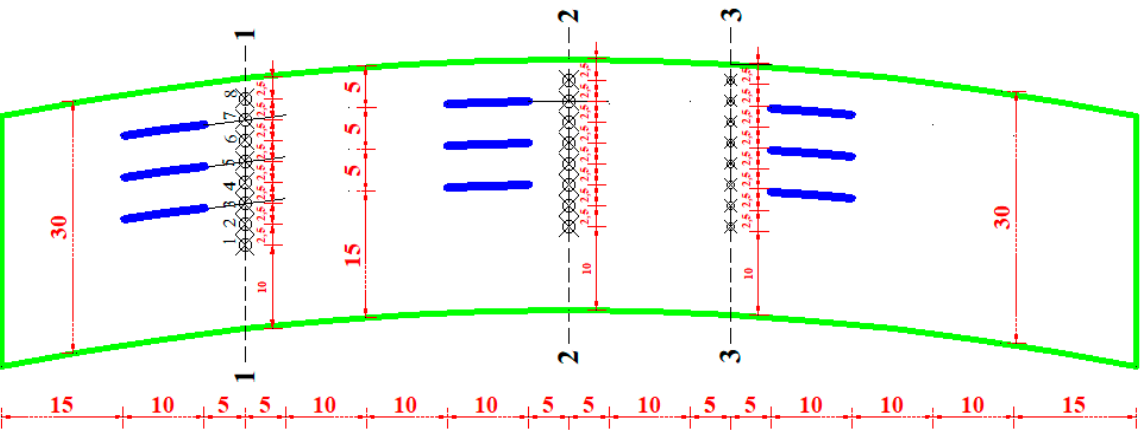
Figure 2. Submerged vane experimental set-up for “with vane” situation: ( a ) Channel top (plan) view, ( b ) Cross section view, ( c ) Section view.